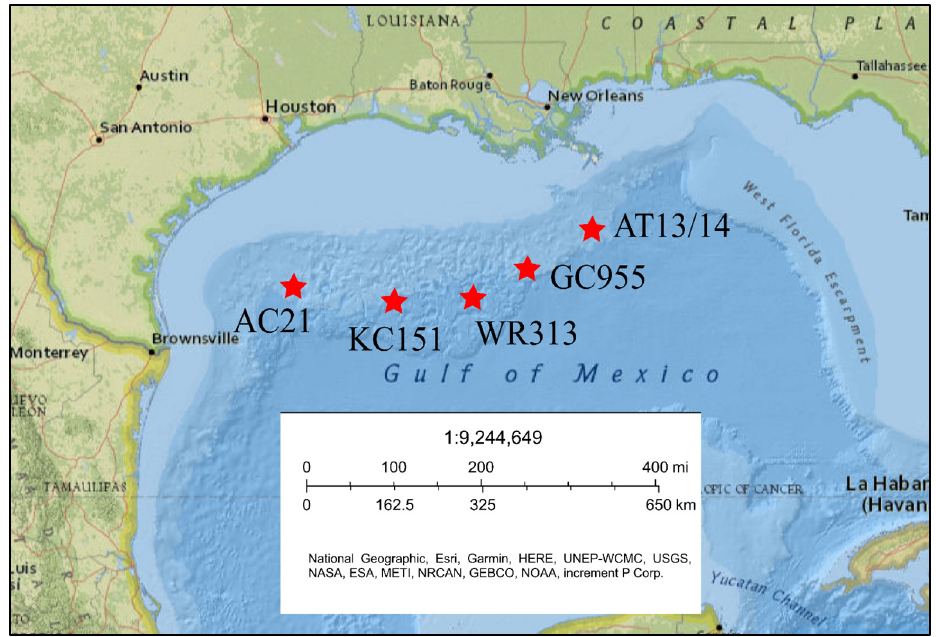
Figure 1. Joint Industry Project sites in the Northern Gulf of Mexico. Five locations, namely, Alaminos Canyon (AC21), Keathly Canyon (KC151), Walker Ridge (WR313), Green Canyon (GC955), and Atwater Valley (AT13/14) were explored for hydrate occurrence and wellbore stability while drilling through hydrate layers [12].